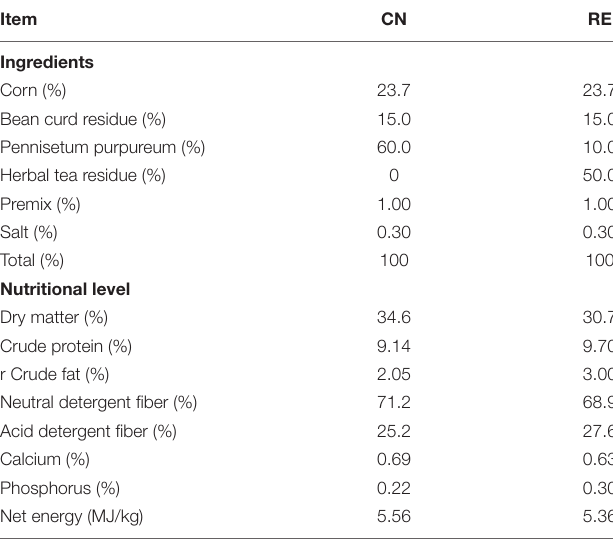
TABLE 1 | Basic diet composition and nutrient level of finishing